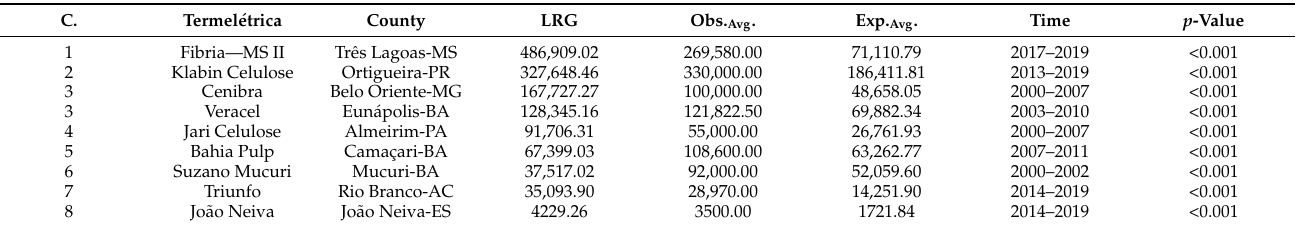
Table 2. Characterization of isolated clusters of forest-based power plants in Brazil,